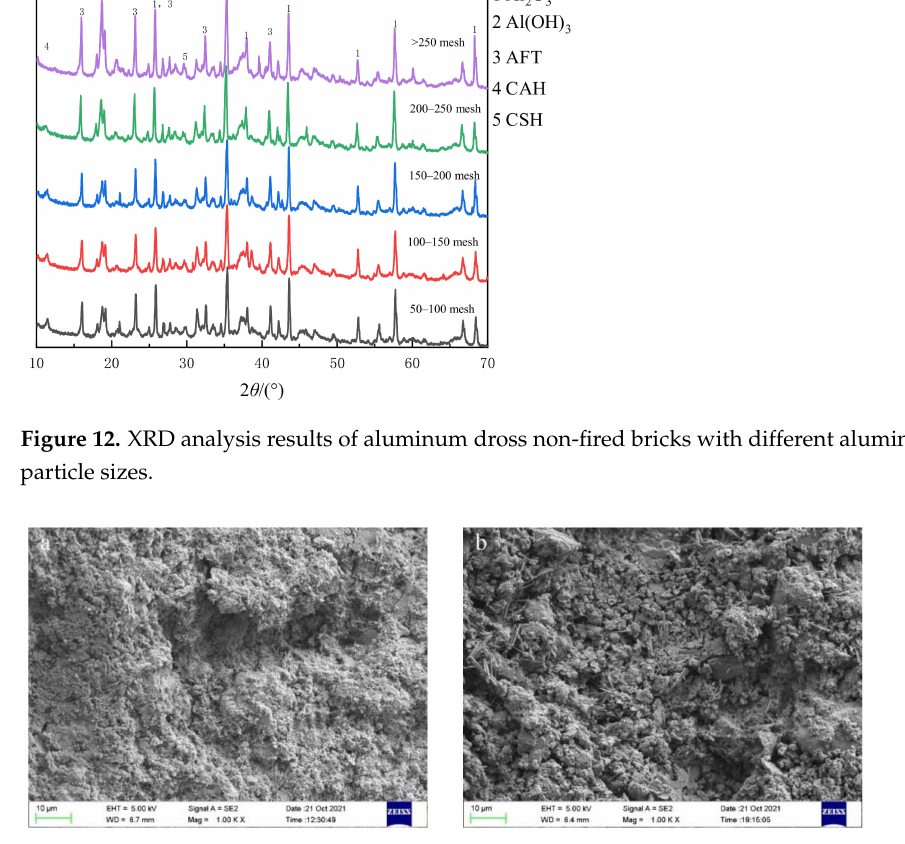
Figure 13. SEM images of non-fired bricks with different aluminum dross particle sizes: ( a ) 100– 150 mesh; ( b ) more than 250 mesh.